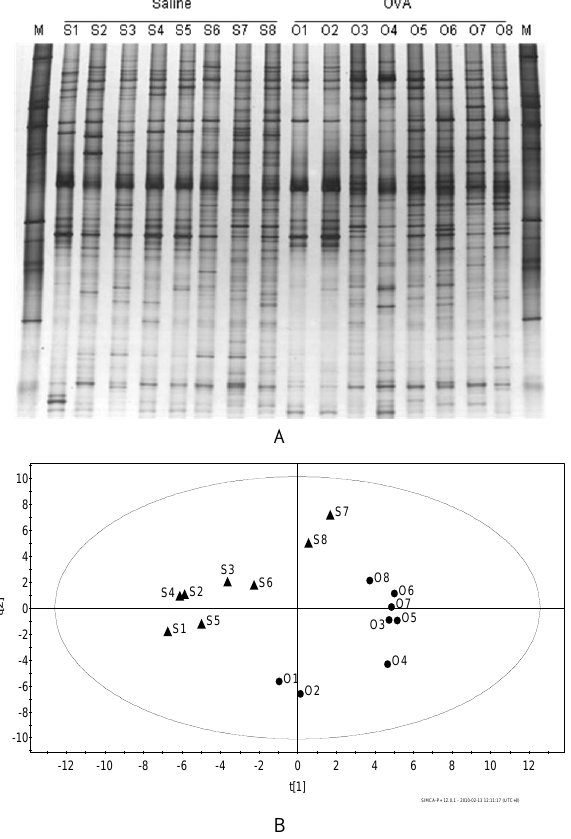
Figure 4. PCA Analysis (B) of DGGE profiles (A) for total bacteria in the colon of saline sensitized (S1 to S8, ▲) and OVA sensitized mice (O1 to O8, ●).